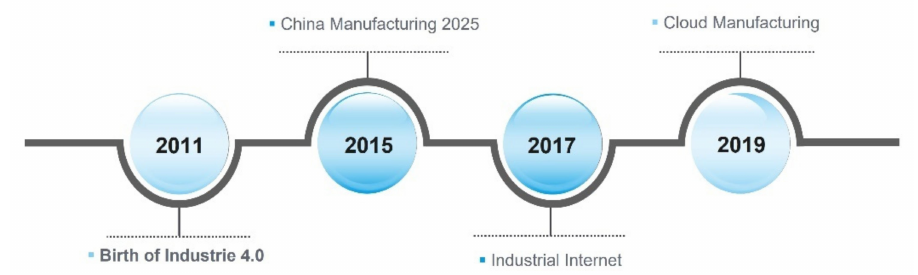
Figure 2. Variants of Industrie 4.0 and the respective time of market emergence in